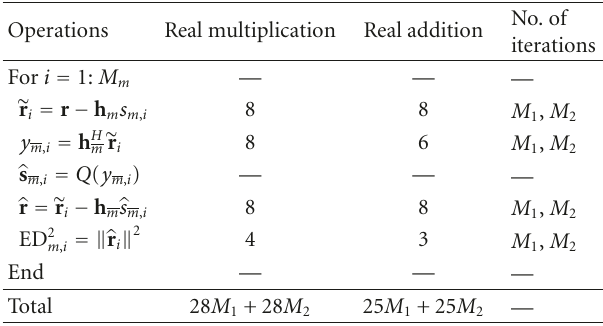
Table 3: Complexity analysis for the proposed scheme II ( N t = N r = 2, per one